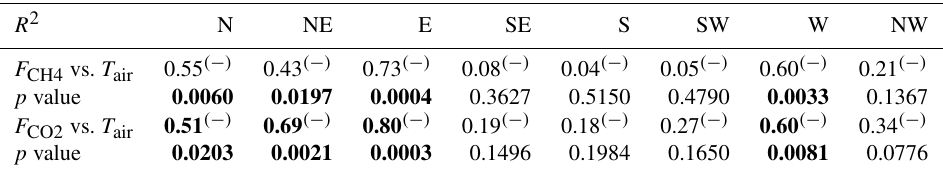
Figure 8. Annual fluxes of carbon dioxide ( F CO2 ) and methane ( F CH4 ) measured by eddy-covariance at the BT tower in central London as a function of (a) wind direction; solid lines are mean annual emissions (2012–2014) without wind sector segregation. Measurement uncertainty (taken as the maximum of monthly uncertainties for each gas) is denoted by a blue ( F CO2 ) and red striped areas ( F CH4 ). (b) Data from plot (a) as a function of population within each wind sector-specific flux footprint area. The spatial extent of the footprint for each wind sector was derived from footprint statistics (Fig. 3) with the approximation that the typical extent was of the order of 10km for NE–SW and 15km for W–N. Population data (source: London Datastore, Greater London Authority, 2016) are on a ward basis (i.e. sub-borough administrative unit). Linear regression (dashed lines), with exclusion of S sector data point for F CO2 , E, S and SE for F CH4 (identified by their wind sector abbreviations). NB: F CO2 and associated uncertainty are divided by 1000 to aid visualization. Table 3. Goodness of fit of the linear regression between wind sector-segregated monthly methane fluxes ( F CH4 ), carbon dioxide fluxes ( F CO2 ) and monthly mean air temperature ( T air ). The superscripts ( − ) and ( + ) denote the sign of slope for each linear regression. p values in bold denote statistical